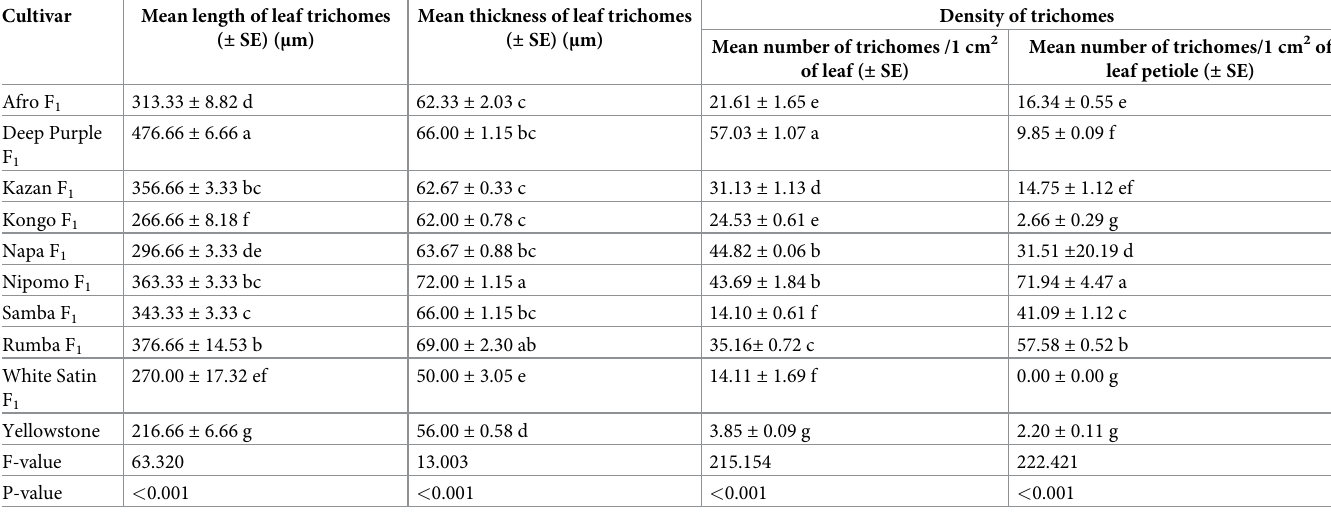
Table 3. Characteristics of leaf and leaf petiole trichomes of 10 carrot genotypes (one-way ANOVA, factor df = 9, error df = 20). Cultivar